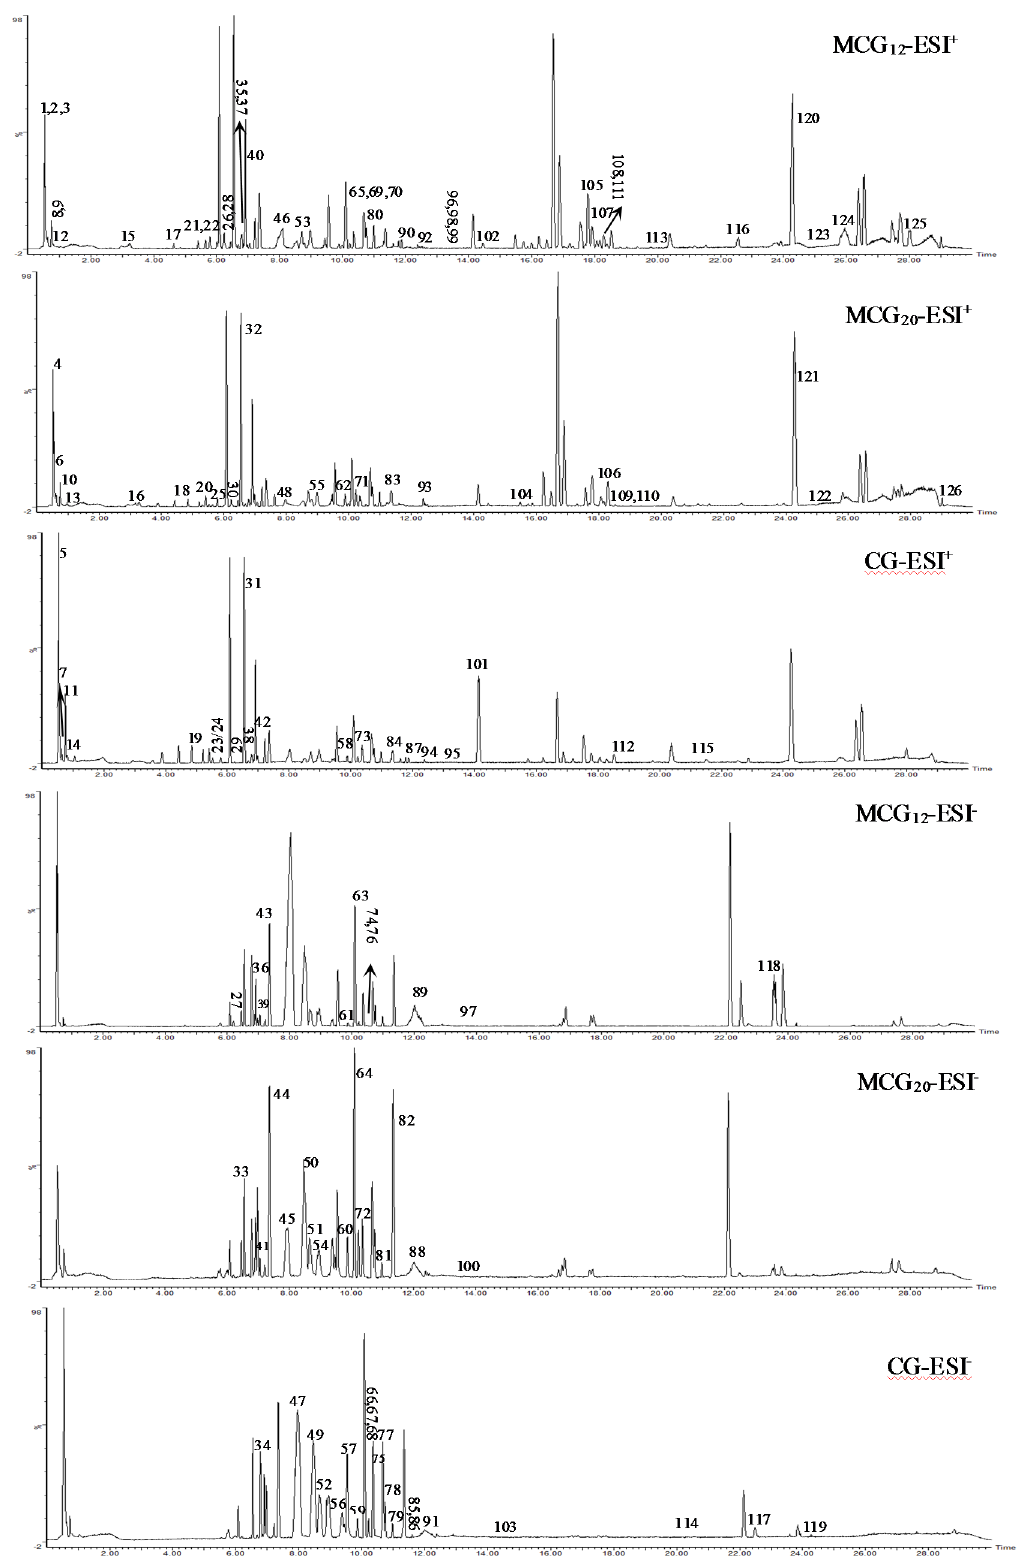
Figure 1. The representative BPI chromatograms of CG and MCG in positive and negative modes.